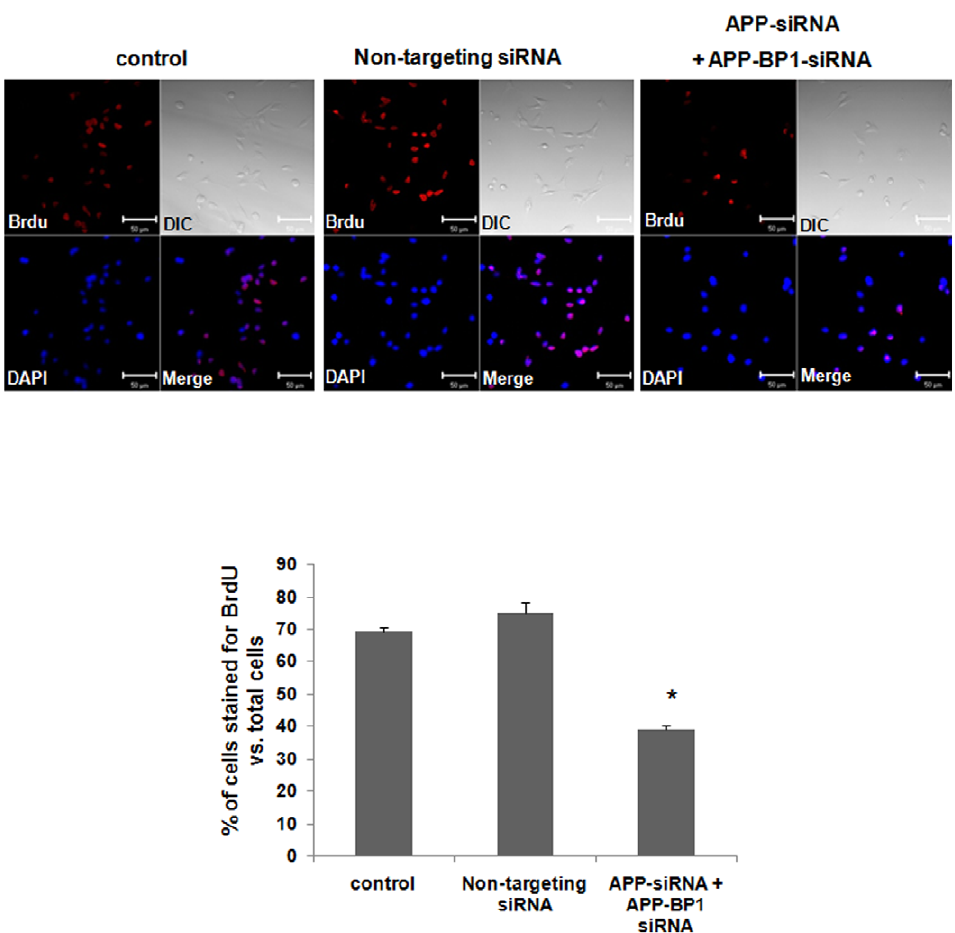
Figure 4. siRNA-mediated knock-down of APP-BP1 and APP significantly down-regulates the proliferation of fetal neural stem cells. Fetal neural stem cells were subcultured in 6-well plates, in proliferating media, and then treated the cells with 10 nM siRNAs. After 24 h, the cells were treated with BrdU (1 m M) for 24 h. We then dissociated the neurospheres, and transferred the cells to new 6-well plates with 12 mm glass coverslips pre-coated with laminin (20 m g/ml). The cells were cultured in the differentiation media without growth factors for 30 min and assessed with immunocytochemistry using an anti BrdU and Cy3-secondary antibodies. DAPI (1 m M) staining shows the location of the nucleus (blue). DIC represents differential image contrast. BrdU immunoreactive cells were calculated in five independent experiments (10 fields were evaluated per each experiment) with respect to the ratio of BrdU stained cells to total cells. Data are expressed as mean 6 SEM values. One-way ANOVA was used to determine statistical significance at p , 0.05 by post hoc analysis via Duncan’s test. Scale bars=50 m